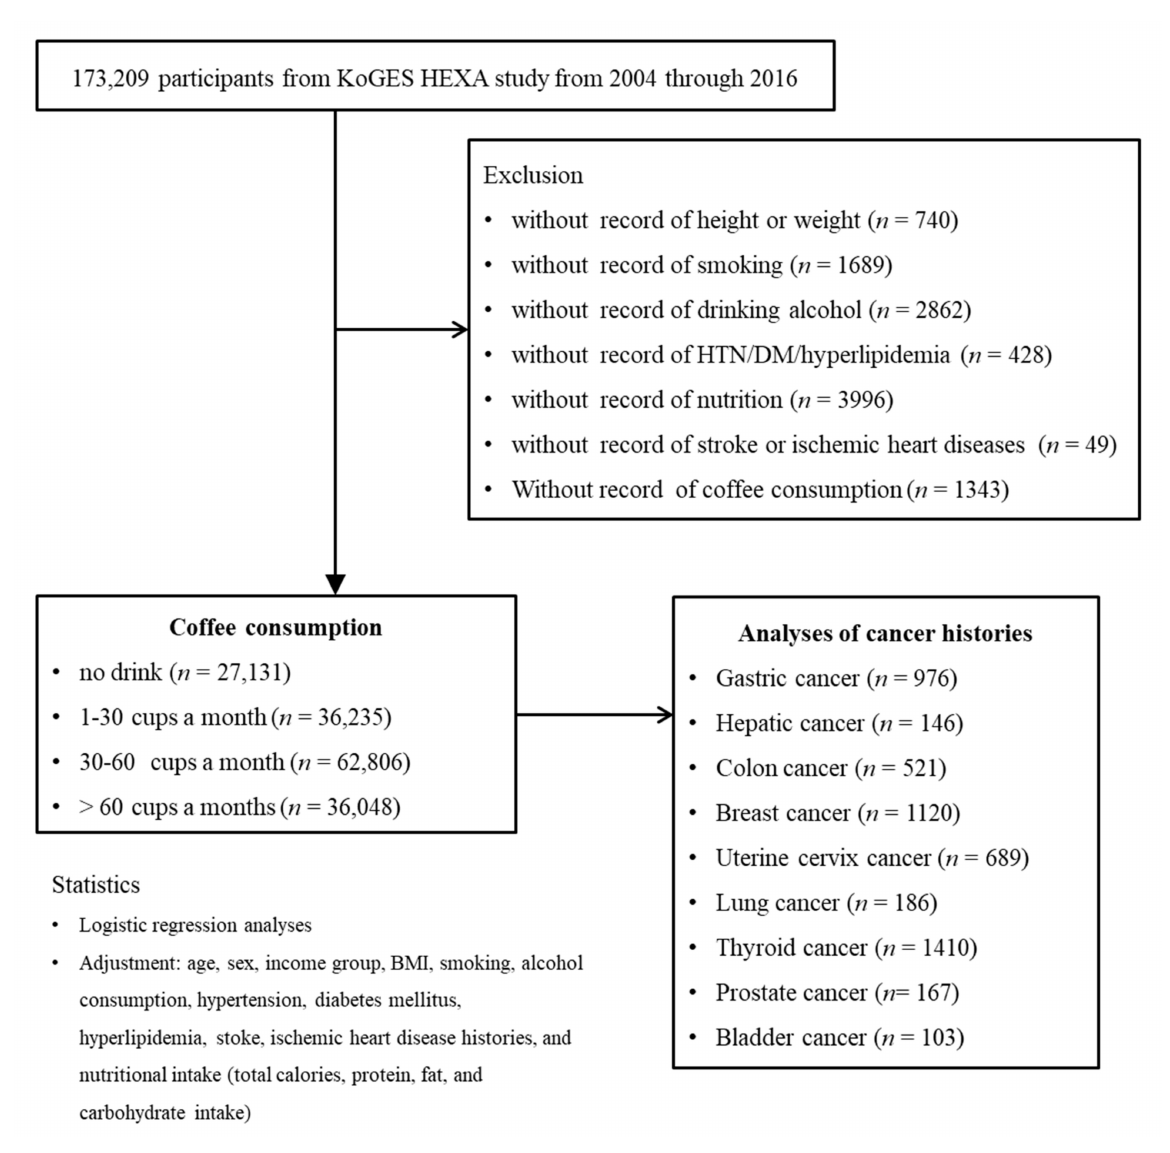
Figure 1. A schematic illustration of the participant selection process that was used in the present study. Of a total of 173,209 participants, 162,220 participants were involved in this study. Participants were categorized into 4 groups (no drink ( n = 27,131): 1–30 cups a month ( n = 36,235), 30–60 cups a month ( n = 62,806), and >60 cups a month ( n =